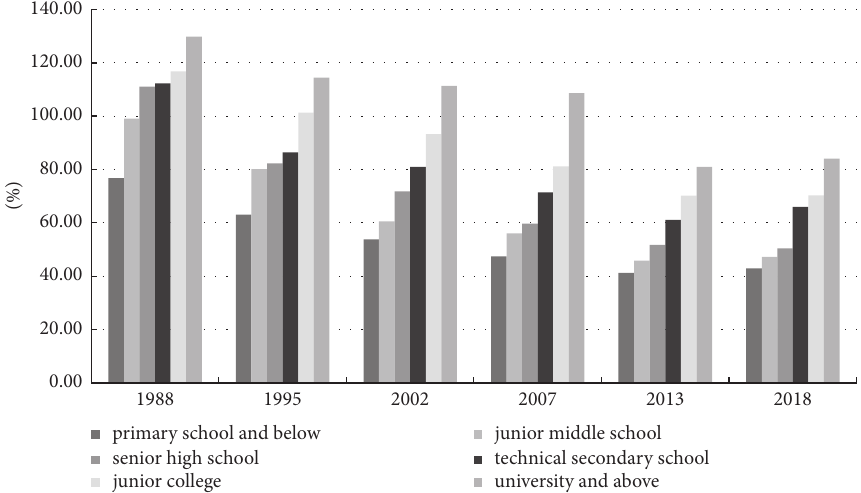
Figure 6: Pension security level under different education